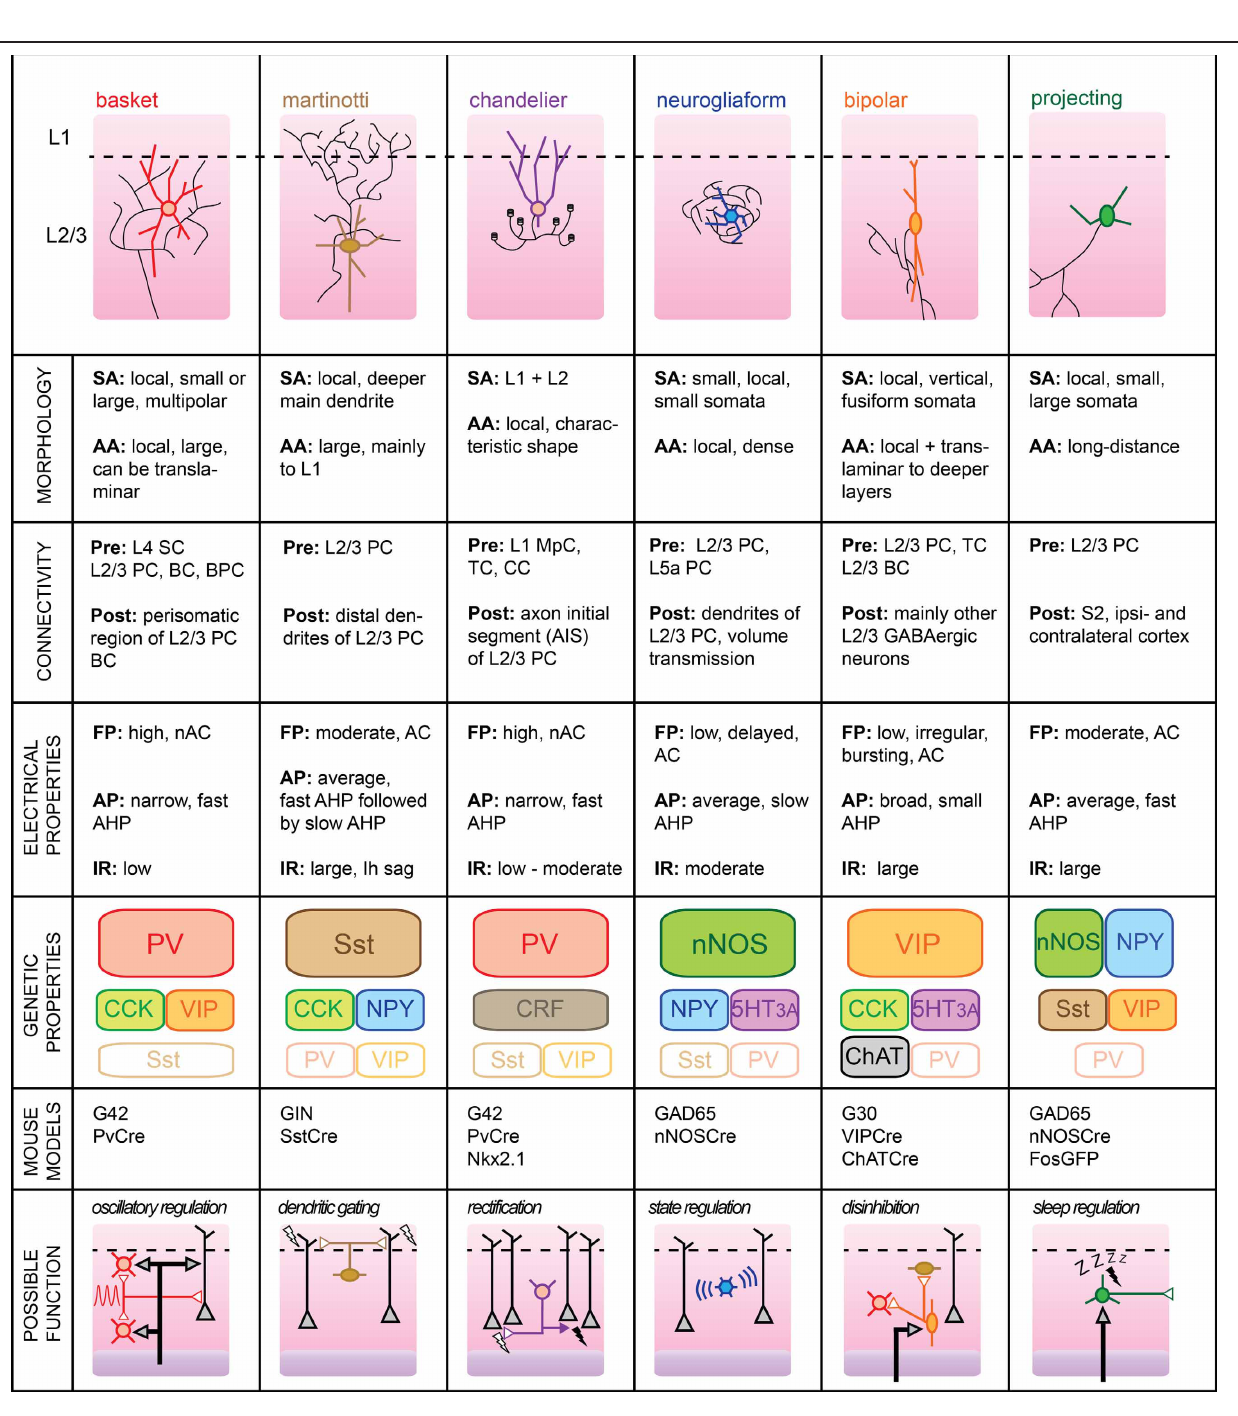
non-accommodating; AP , action potential; AHP , after-hyperpolarization; IR , input resistance. Genetic properties (filled top boxes: expressed markers; middle boxes: markers expressed in subsets; bottom empty boxes: markers not expressed), PV , parvalbumin; Sst , somatostatin; NPY , neuropeptide Y; VIP , vasoactive intestinal polypeptide; CCK , cholecystokinin; CRF , corticotropin-releasing factor; nNOS , neuronal nitric oxide synthase; 5HT3A , serotonin receptor 3A; ChAT , choline acetyltransferase. Bottom : schematic representation of possible functional role within the local circuit. Black arrows indicate excitatory inputs; reversed white triangles represent inhibitory